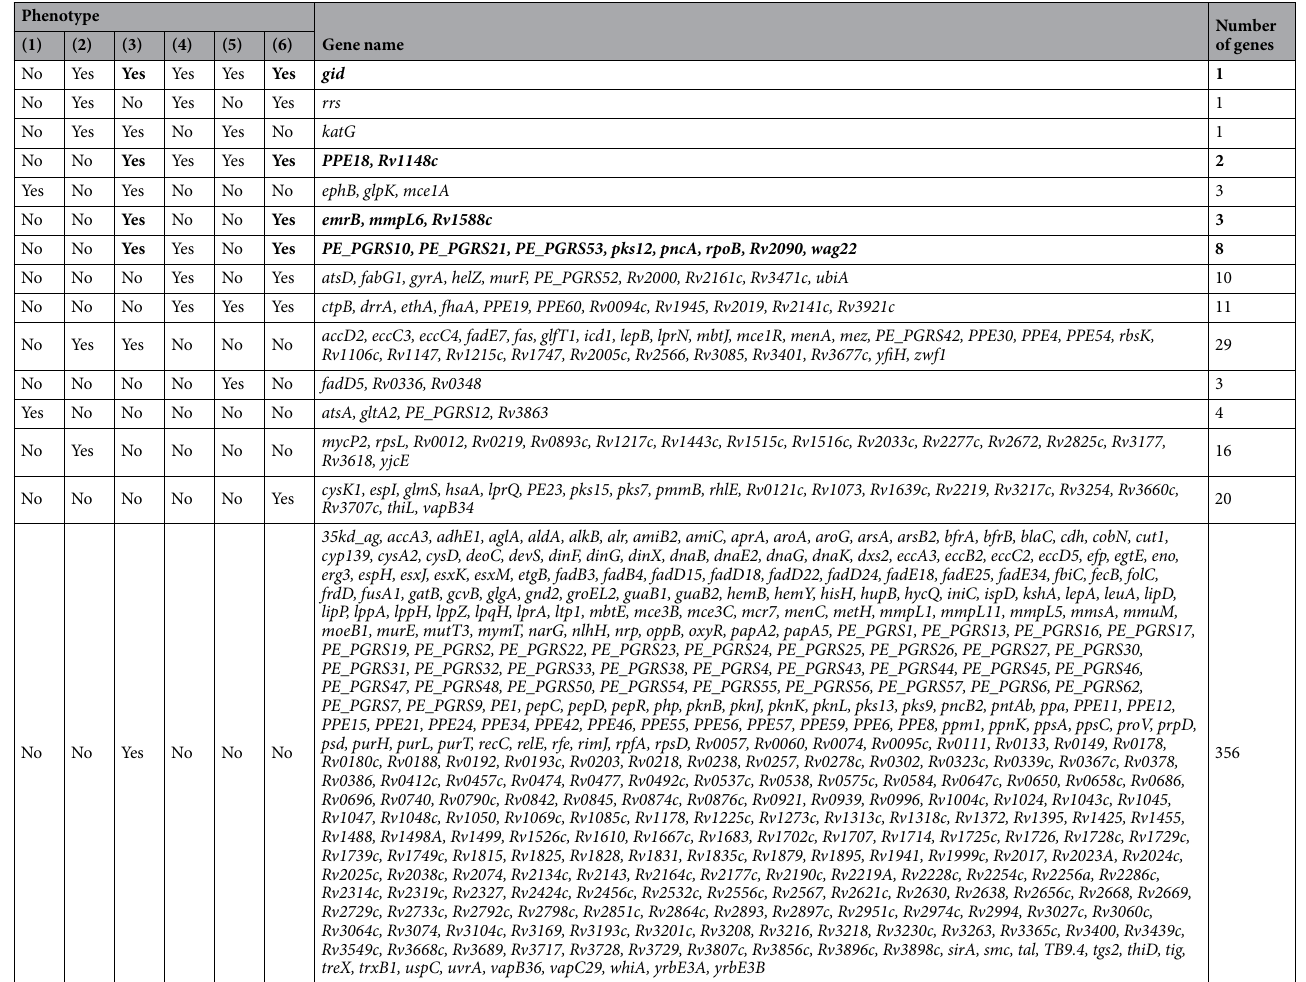
Table 2. Genes harboring k-mers significantly associated with different phenotypes (from (1) to (6)) in Hanoi and KwaZulu-Natal studies. Phenotype (1): clustered strains (cluster[ + ]) (pairwise SNV difference between two isolates is no more than five SNVs) in Hanoi’s study cohort; (2): strains harboring katG -S315 T mutation (S315 T[ + ]) in Hanoi’s cohort; (3): cluster[ + ]/S315T[ + ] in Hanoi’s cohort; (4): cluster[ + ] in KwaZulu-Natal’s cohort; (5) S315T[ + ] in KwaZulu-Natal’s cohort; (6): cluster[ + ]/S315T[ + ] in KwaZulu-Natal’s cohort; SNV: single nucleotide variant. The genes in bold are associated with cluster[ + ]/S315T[ + ], and shared between Hanoi and KwaZulu-Natal study